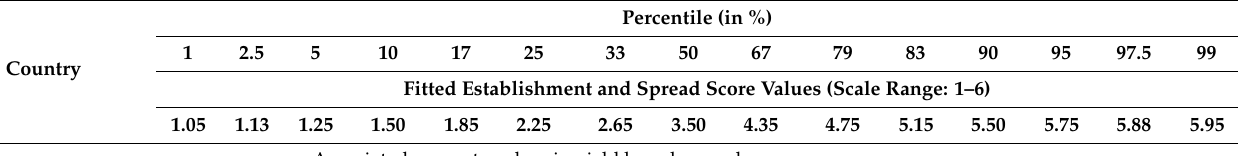
Table 1. The fitted values of the uncertainty distribution on the yield loss (%) on olive, grapes, Citrus spp., and almonds take into consideration the uncertainty range and percentiles of EFSA [35] as shown in Table